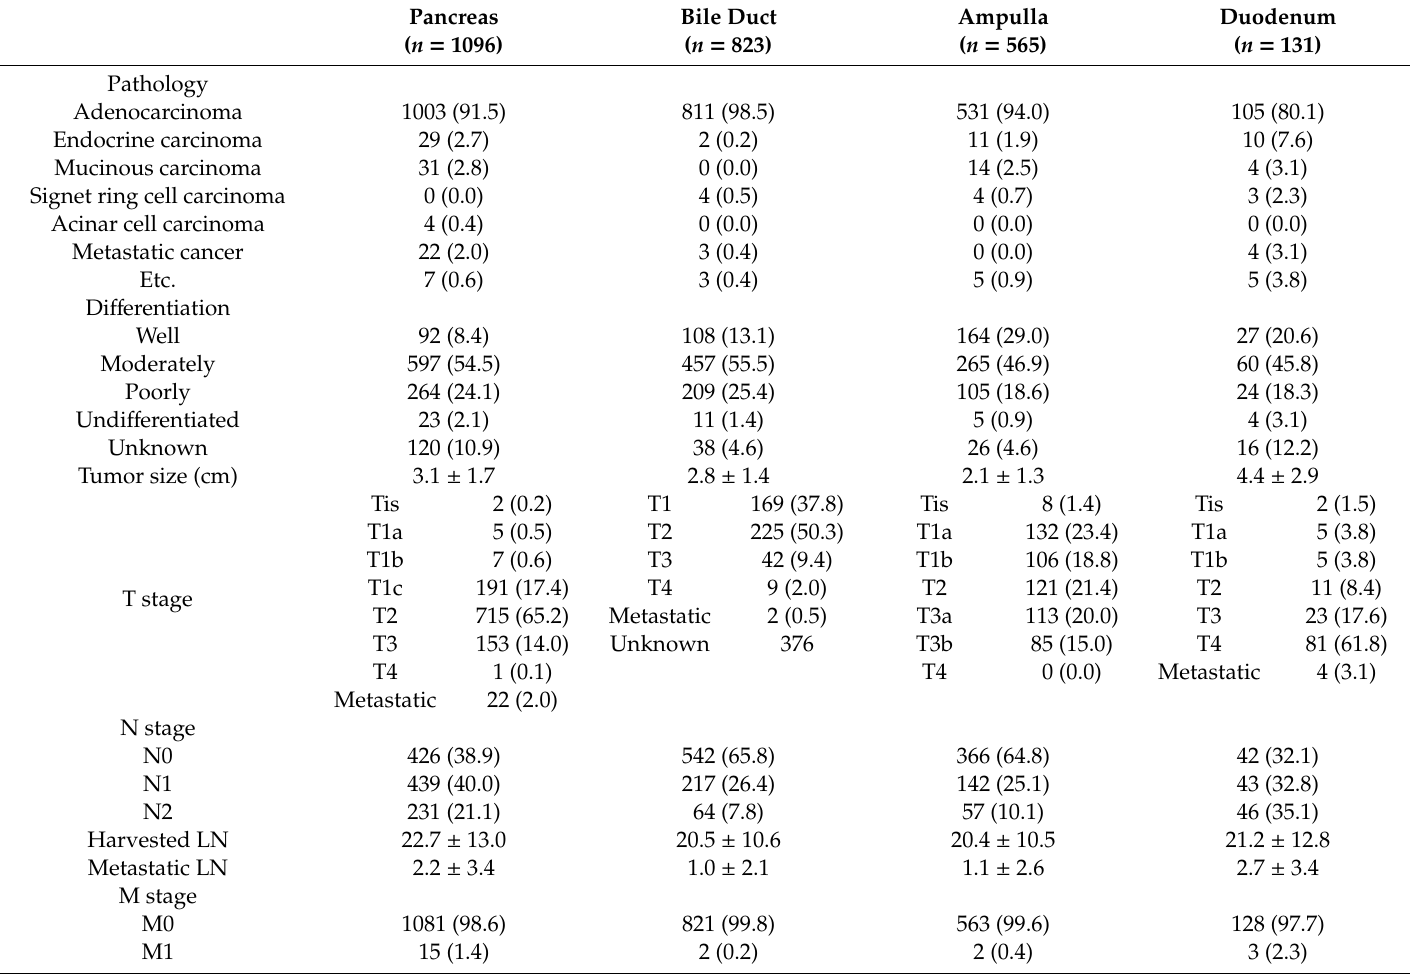
Table 3. Pathologic and postoperative features of 2615 patients with malignant tumor (Mean ± Standard deviation and number